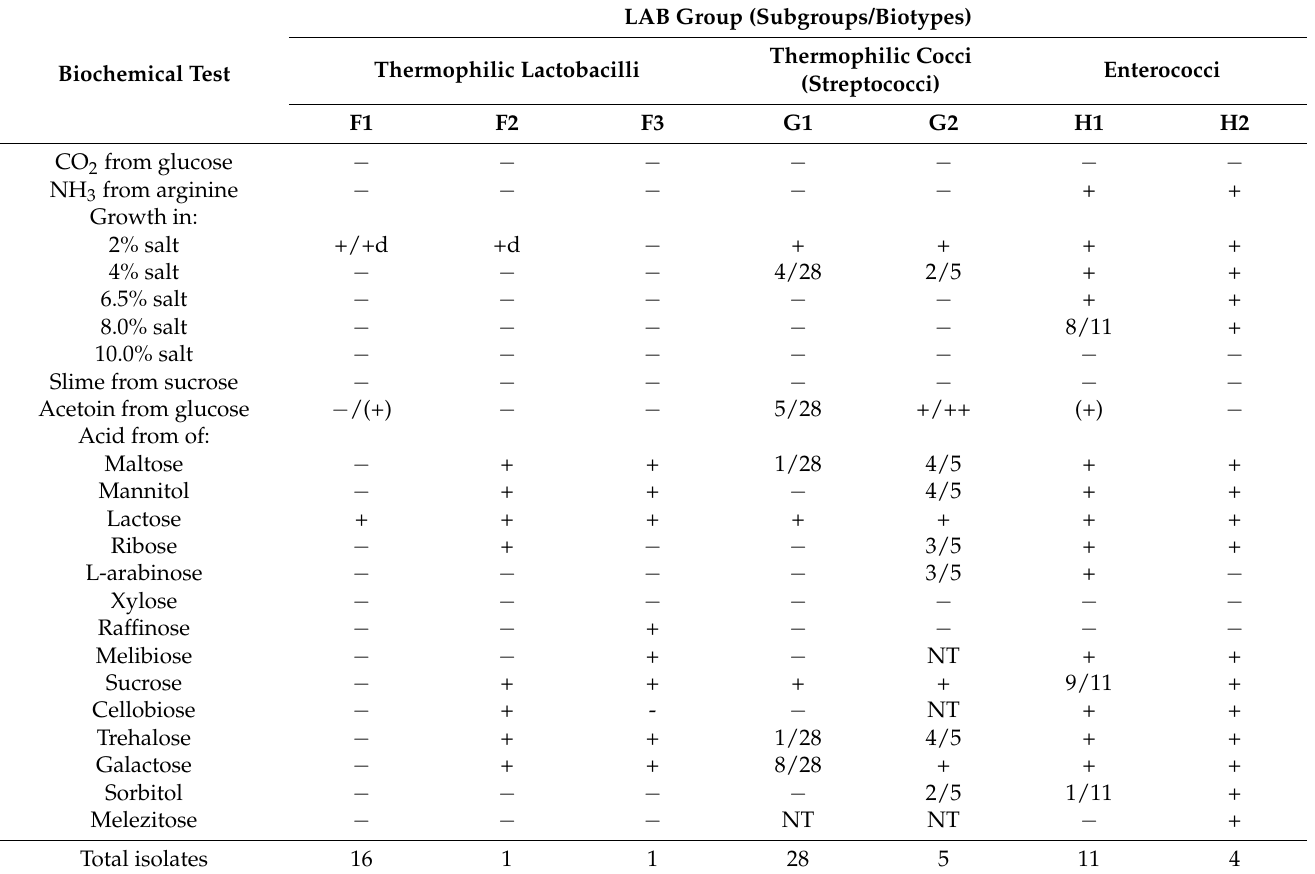
Table 6. Biochemical characterization of 66 thermophilic LAB isolates from four Galotyri PDO